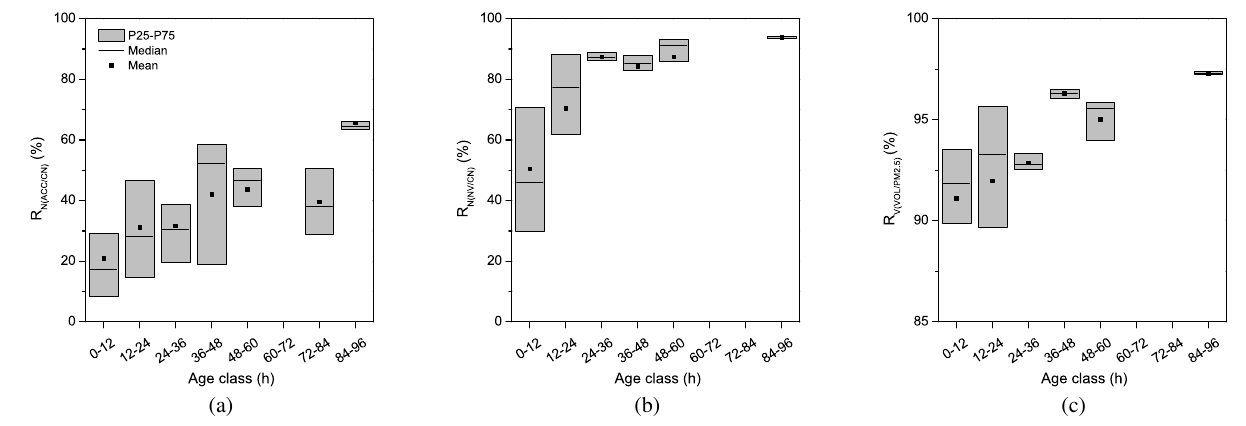
Fig. 8. Classification of measurements into time intervals of the maximum contribution of emissions along the air mass transport pathway within in the last 120 hours. Panel (a) shows the ratio of accumulation mode particles to total number concentration, panel (b) the ratio of non volatile particles to total number concentration and panel (c) the ratio of the volatile aerosol volume to the total aerosol volume. Median, mean and 1st and 3rd quartiles (P25, P75) are given.